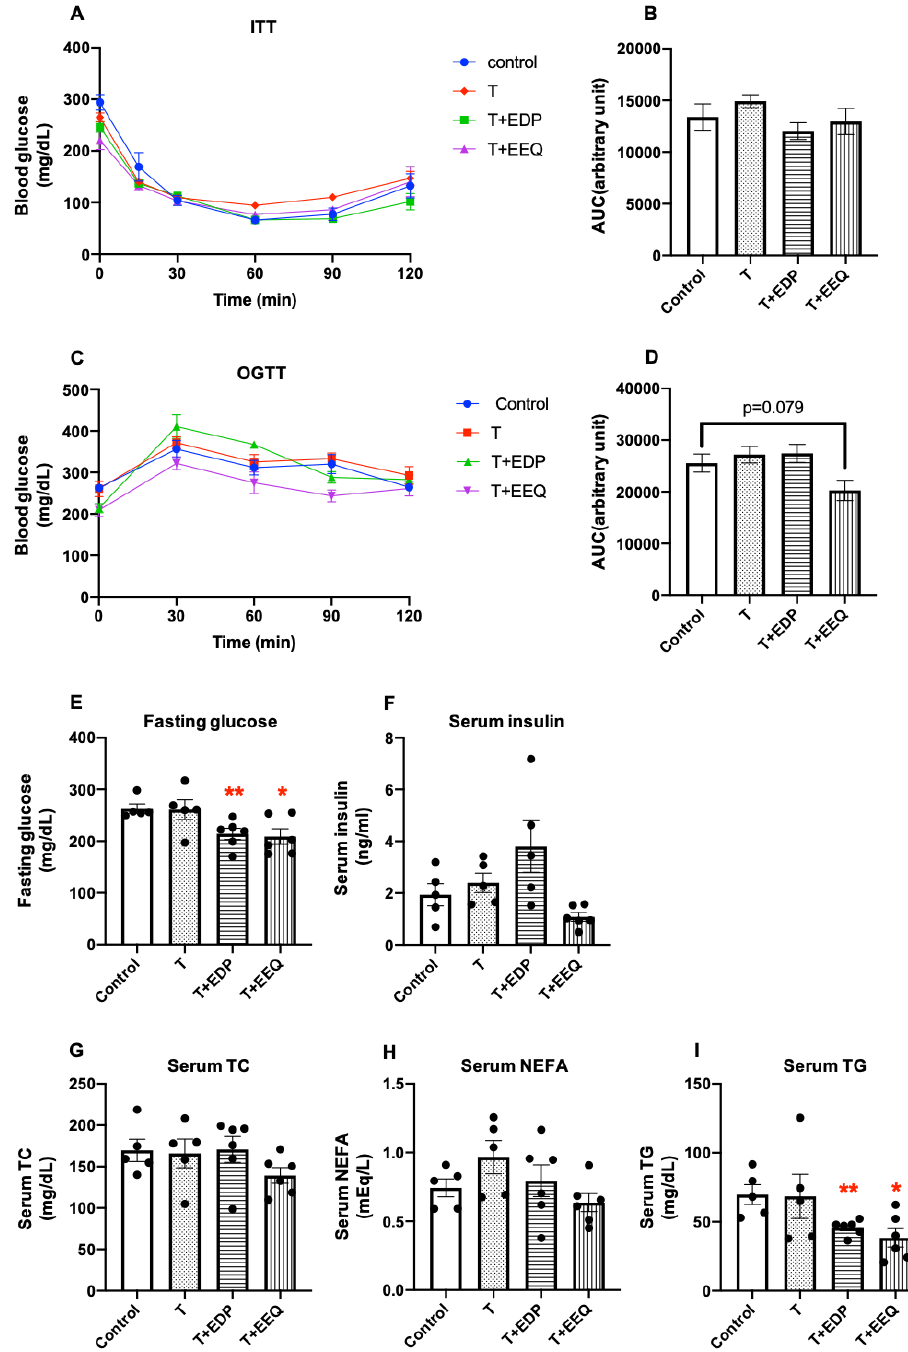
Figure 2. 17,18-EEQ or 19,20-EDP combined with t -TUCB delivered via mini osmotic pump decreased the fasting glucose and serum TG levels in diet-induced obesity. Male C57BL/6J mice fed with a high-fat diet (45% kcal from fat) were treated with t -TUCB (3 mg/kg/day) alone or combined with 19,20-EDP (0.05 mg/kg/day) (T + EDP) or 17,18-EEQ (0.05 mg/kg/day) (T + EEQ) by osmotic minipump implantation for 6 weeks, as described. Insulin tolerance test and the area under the curve (AUC) ( A , B ), oral glucose tolerance test and the area under the curve ( C , D ), fasting glucose levels ( E ), serum insulin ( F ), serum TC ( G ), NEFA ( H ), and TG levels ( I ) after 6 weeks of implantation are shown. Data = the mean ± SEM ( n = 5–6). *, ** = p < 0.05 and p < 0.01 compared to the controls, respectively.